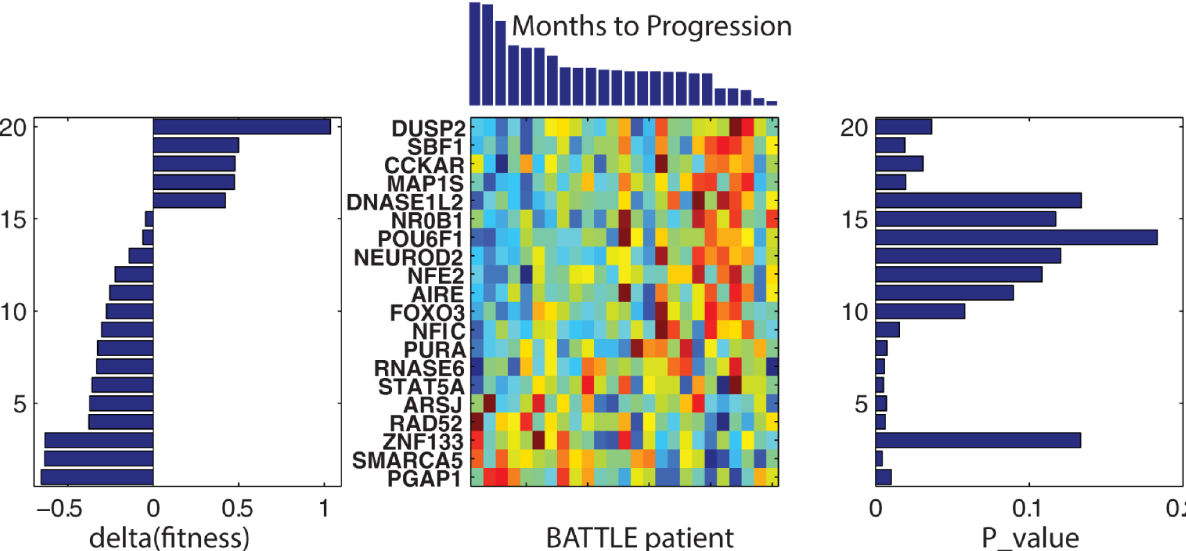
Fig 6. Erlotinib meta-cluster (rows 49–55):The middle panel displays the expression profiles for the genes in meta-cluster(rows 49–55). Expressions are orderedvertically accordingto their contribution to the total pathway fitness score, delta(fitness), displayedin the left panel. The right panel displaysthe statistical significance(p_value) for either the t-test comparing the upper and lower 20 th percentilesof patient responses or the correlationof gene expression to Months to Progression(shown abovethe middle